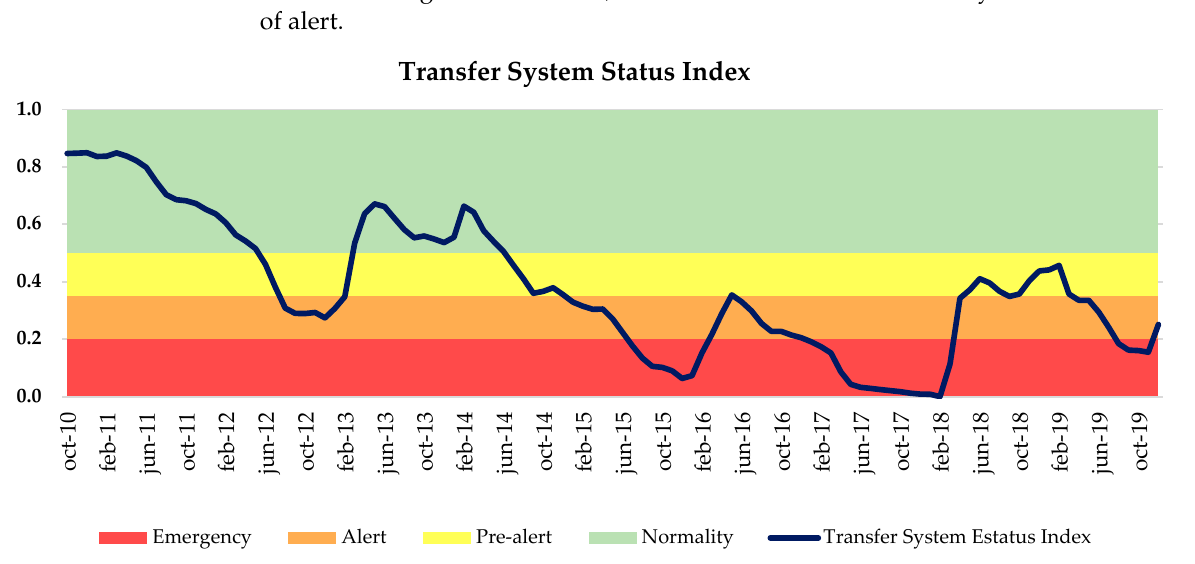
Figure 7. Evolution of the Transfer System Status Index, period October 2010-December 2019. Source: own elaboration based on [63].